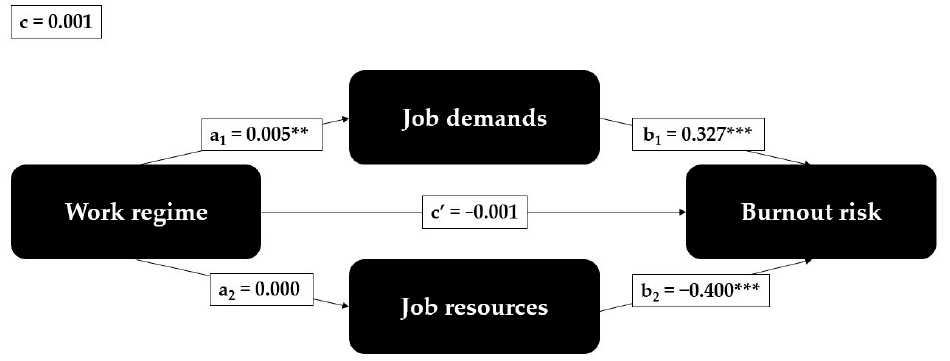
Figure 2. Estimation of the conceptual model. Notes. Presented statistics are the path coefficient estimates. Stars indicate the significance level: *** p < 0.001; ** p < 0.01